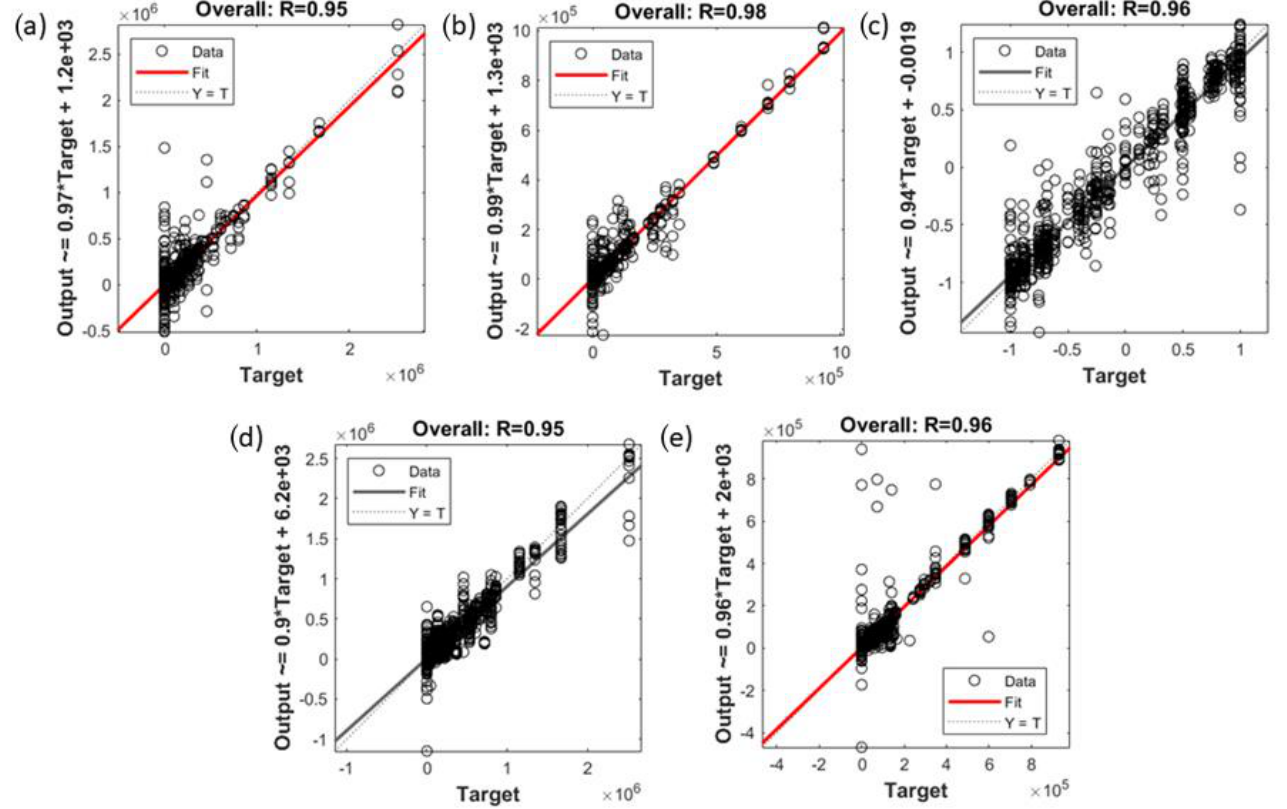
Figure 5. The overall correlation of the regression ANN models developed to predict rice aroma and physicochemical quality for ( a ) Model 3; inputs: first derivative of NIR absorbance; targets: raw rice aroma, ( b ) Model 4; inputs: first derivative of NIR absorbance; targets: cooked rice aroma, ( c ) Model 5; inputs: first derivative of NIR absorbance; targets: cooked rice physicochemical quality, ( d ) Model 6; inputs: e-nose outputs; targets: raw rice aroma, and ( e ) Model 7; inputs: e-nose outputs; targets: cooked rice aroma.